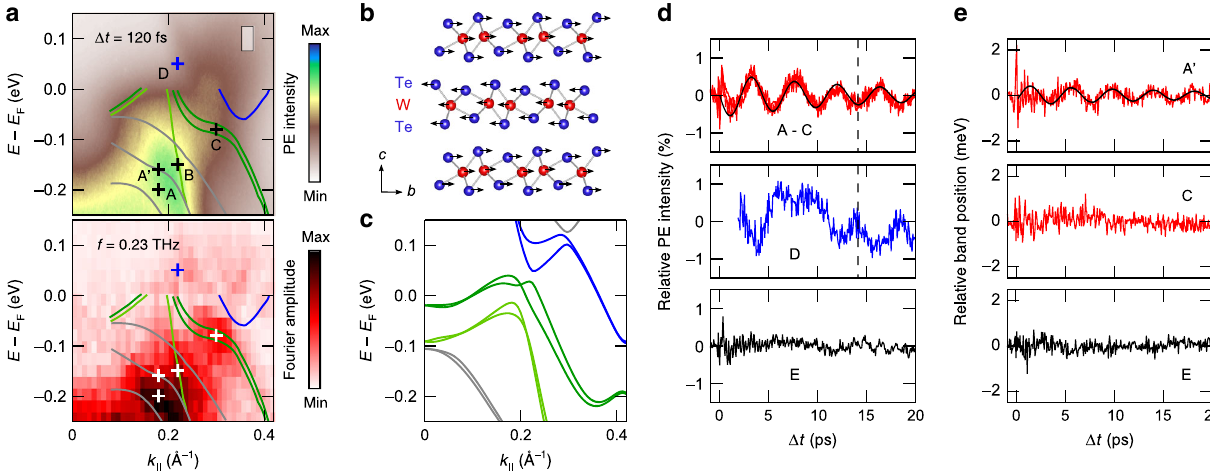
Fig. 4 Electronic structure response to the shear mode excitation. a Close-ups of the ARPES intensity map near E F at Δ t = 120 fs (top) and the corresponding 0.23 THz Fourier map (bottom). The data is overlaid with experimental band dispersions from ref. 11 . Surface bands were omitted for the sake of clarity. Crosses mark positions of ROI A – D and A ′ . The Fourier map was generated from ARPES intensity maps that were binned over regions of 23 meV × 0.01 Å − 1 . b Schematic illustration of the atomic motion upon excitation of the interlayer shear mode 31 . c Calculated bulk band structure along the Γ – X direction. d PE intensity transients of ROI A – E. The transients of ROI A – C (top graph) can barely be discerned and are all displayed in red. The size of the integration area used to generate the transients is indicated by the gray-shaded box in the ARPES data shown in a . e Peak shift analysis of ROI A ′ , C, and reference region E marked in Fig. 3a. All transients in d and e are background-corrected (Supplementary Note 3). The black lines in the top graphs of d and e are fi ts of a damped sinusoidal